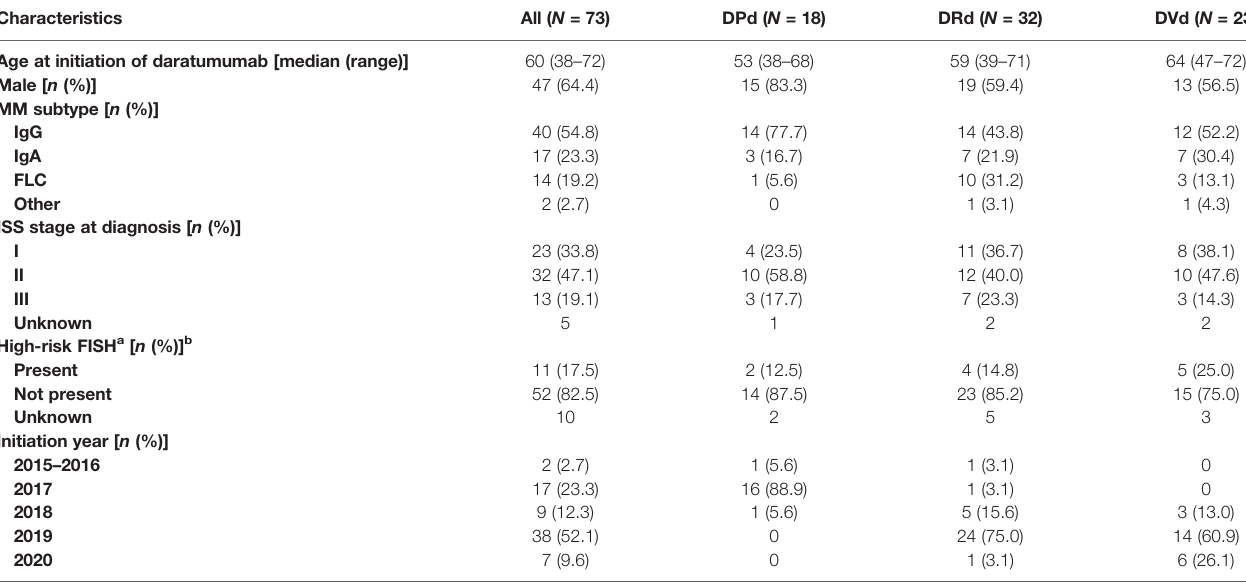
TABLE 1 | Patient characteristics at diagnosis for the daratumumab combination treatment groups.